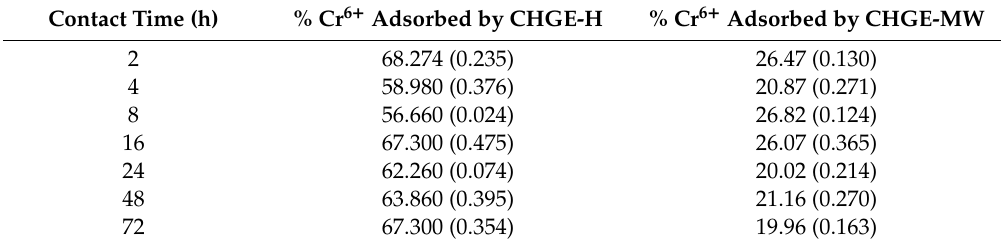
Table 2. The variation of Cr 6 + (%) adsorption by 0.3 g of CHGE with the contact time. Contact Time (h)